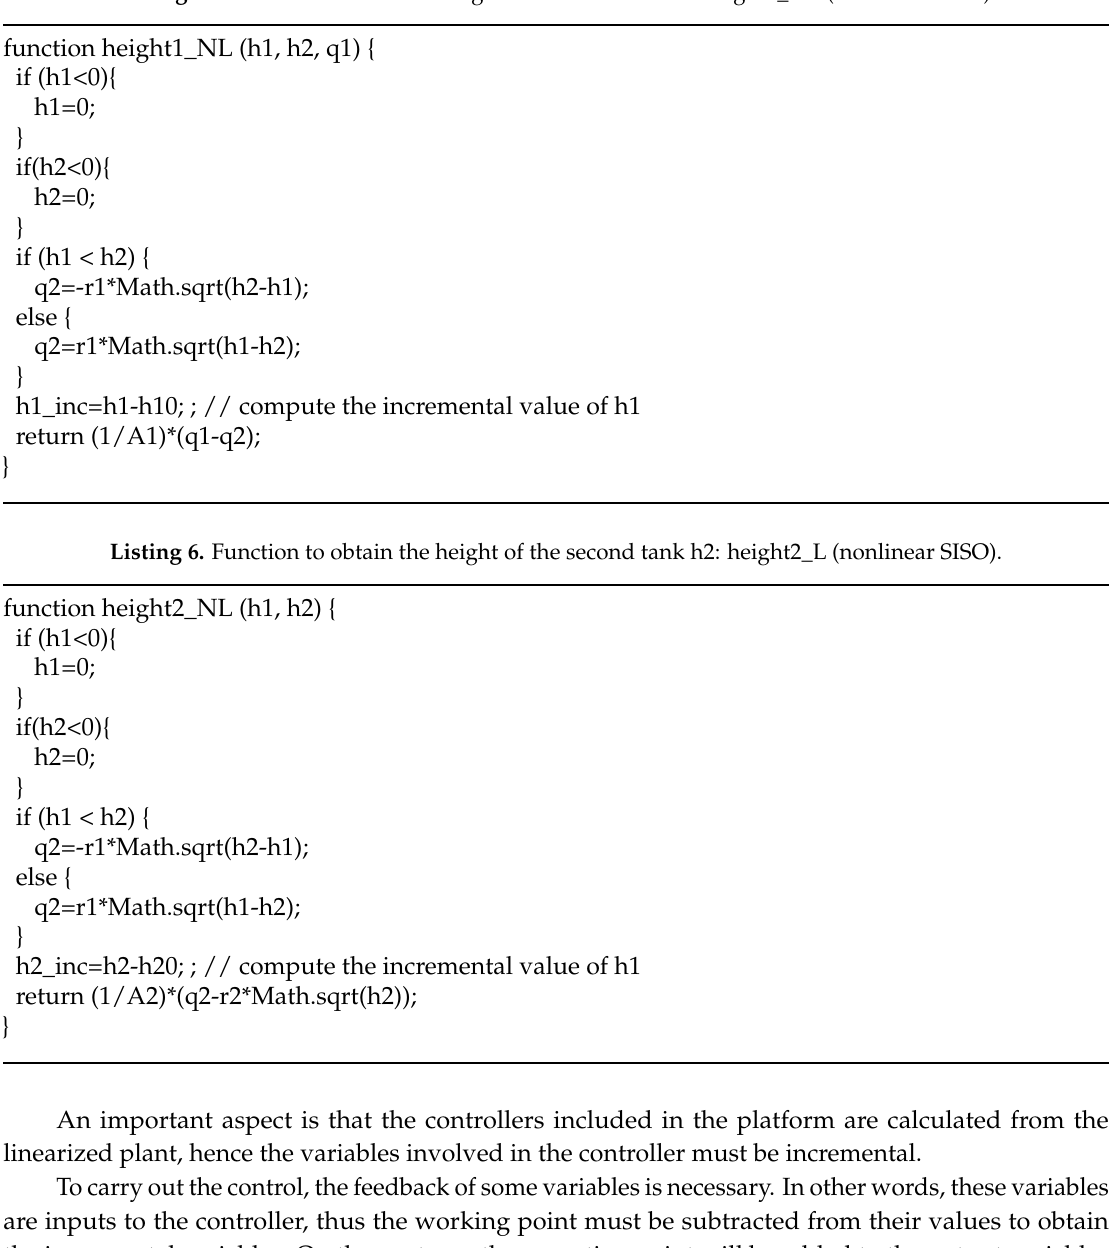
Listing 5. Function to obtain the height of the first tank h1: height1_NL (nonlinear SISO).